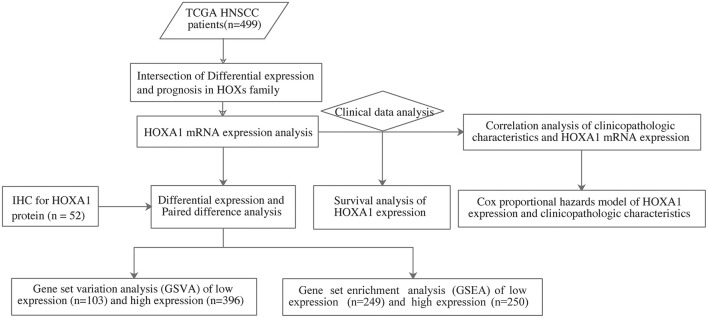
The flow chart showing the scheme of our study on HOXA1 as an independent prognostic indicator for HNSCC.